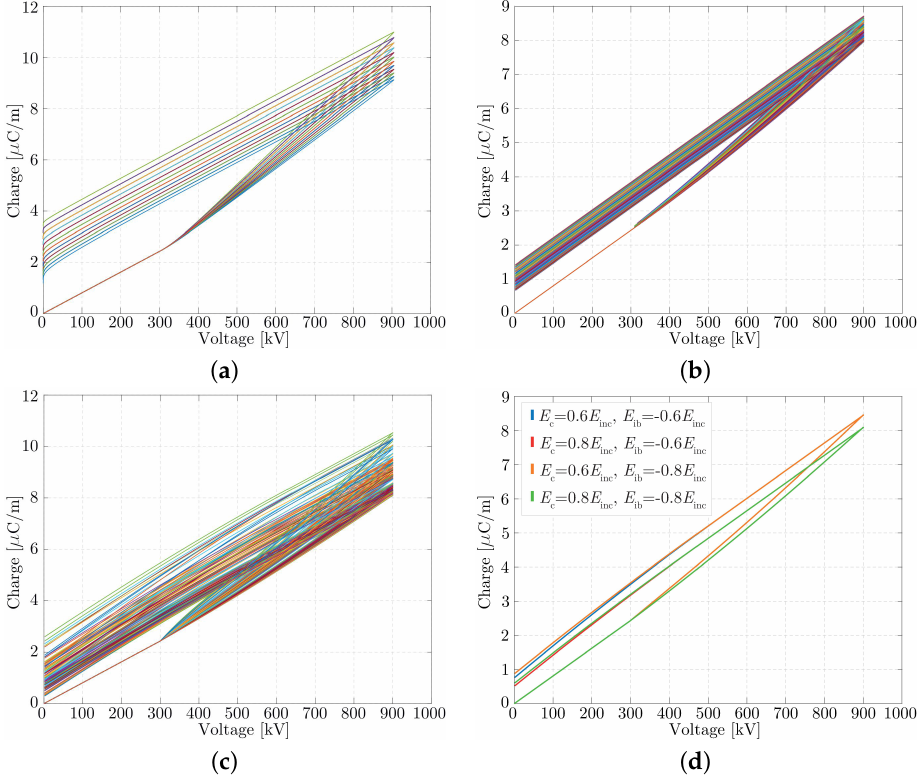
Figure 8. Charge-voltage loops displaying the sensitivity of physics-based models to the variation of the input parameters. ( a ) Correia de Barros, ( b ) Malik, ( c ) Cooray, ( d ) Cooray